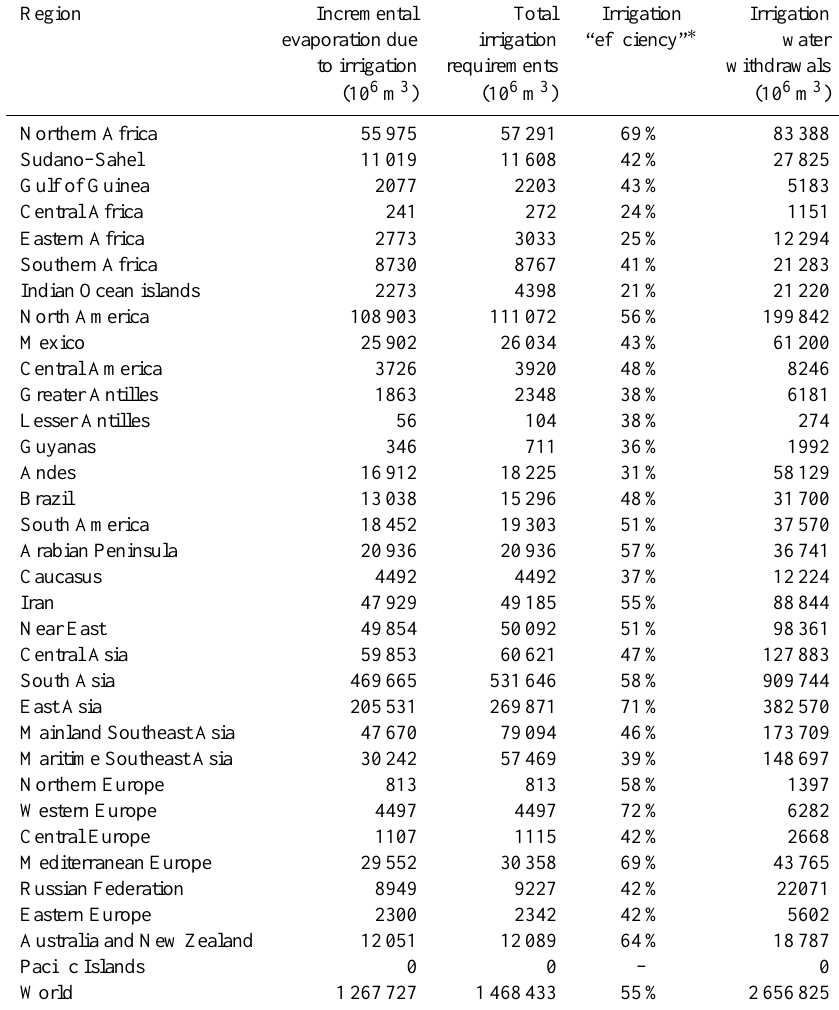
Table 7. Water use in agriculture per hydrological region.